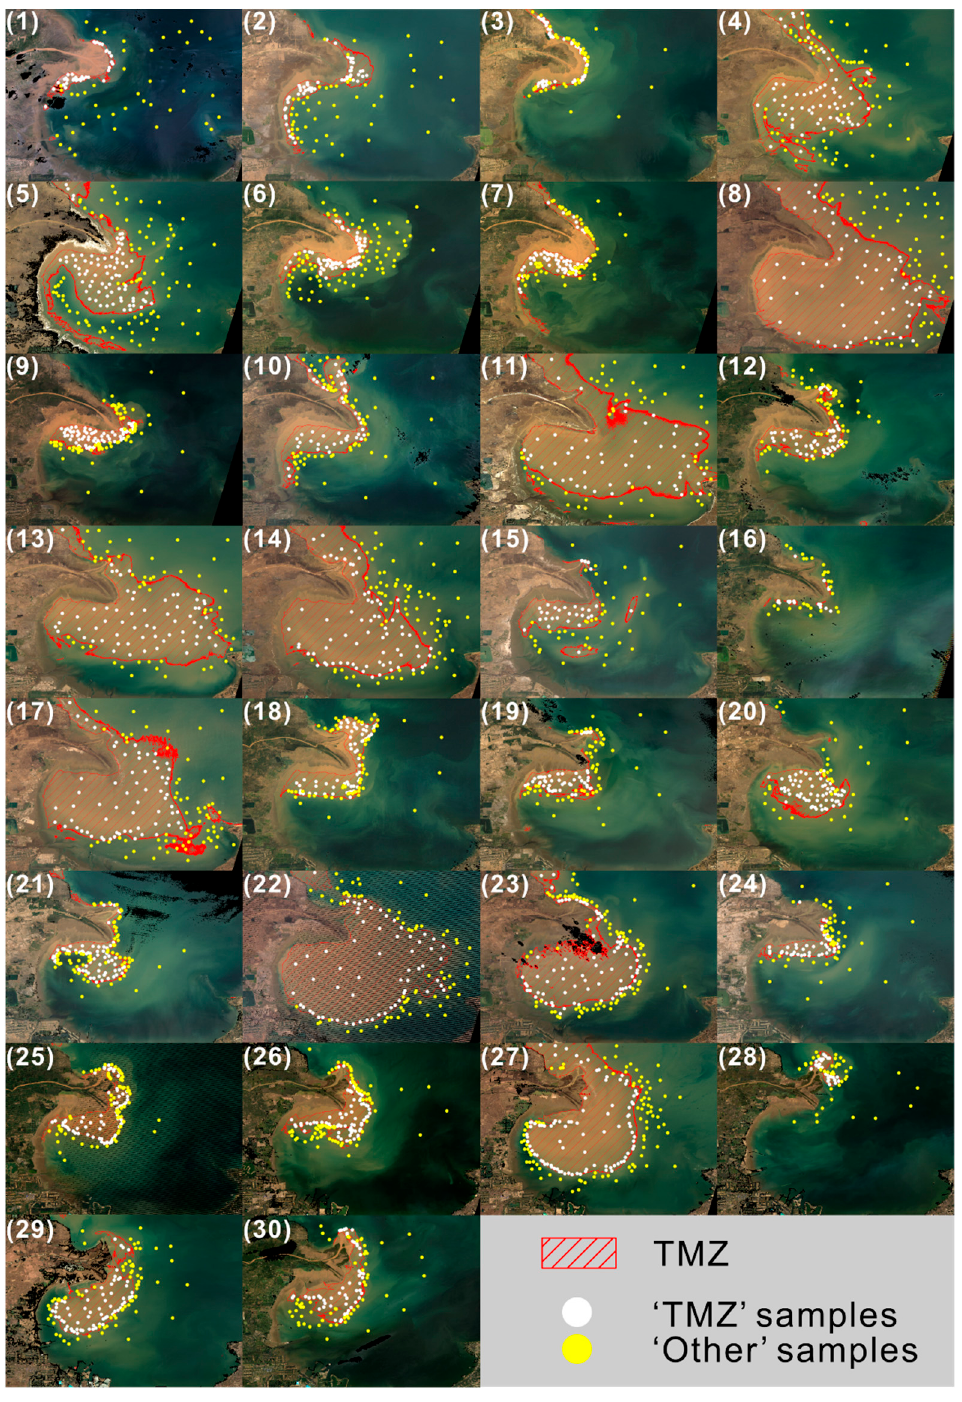
Figure 5. Presentation of the randomly selected 30 Landsat true-color images with their derived TMZ maps and validation samples. Images ( 1 – 30 ) are sorted by date in an ascending order. The detailed information of these images is in Table S1.